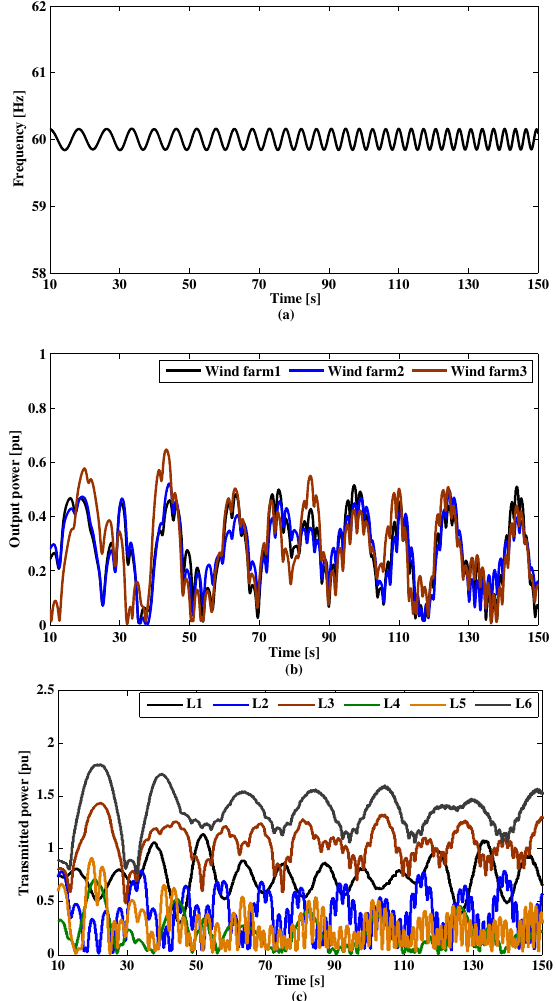
Figure 10. Case 1 result. ( a ) System frequency. ( b ) Generated output power of wind farms. ( c ) Transmitted